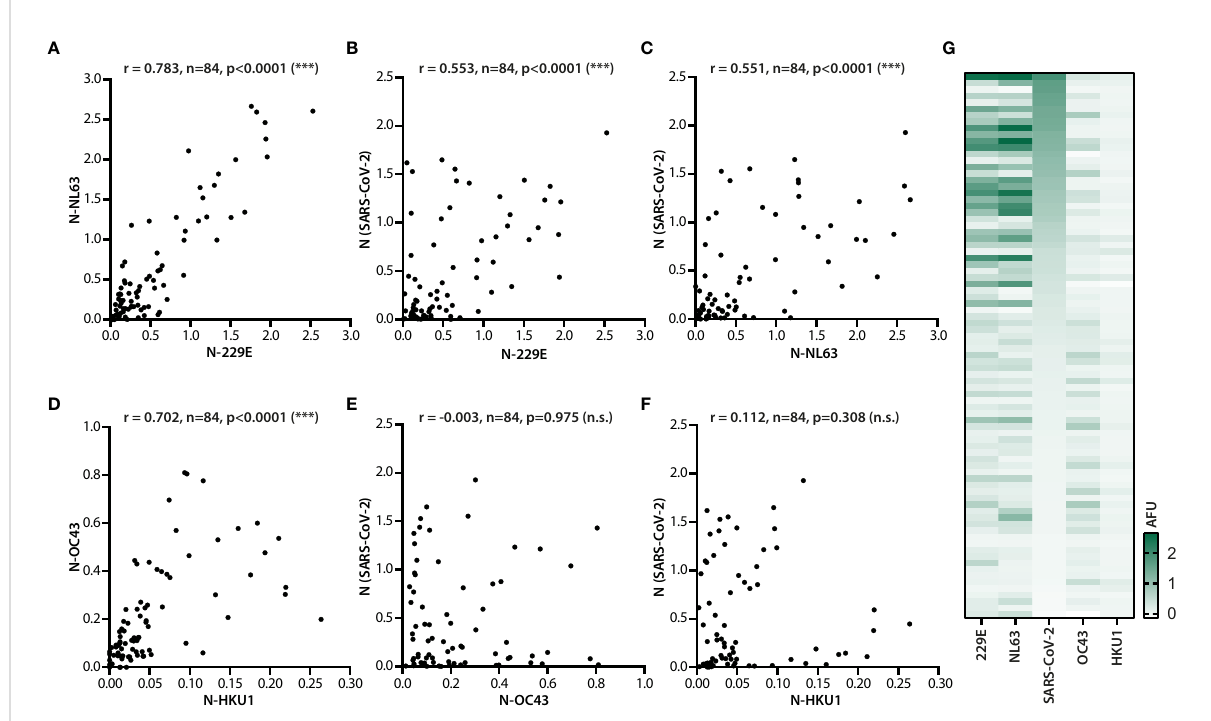
FIGURE 3 Correlation of IgG responses against N of different coronaviruses. Serum samples of 84 donors (n=84) were analyzed for IgG responses against N of SARS-CoV-2 and N of endemic coronaviruses 229E, NL63, OC43 and HKU1. (A) Correlation analysis of the antibody response against N of alphacoronaviruses NL63 and 229E. Correlation of the antibody response against N of SARS-CoV-2 and 229E (B) , as well as SARS-CoV-2 and NL63 (C) . Correlation analysis of the antibody response against N of betacoronaviruses OC43 and HKU1 (D) , N of SARS-CoV-2 and OC43 (E) , and N of SARS-CoV-2 and HKU1 (F) . Spearman correlation coef fi cient and p values are displayed. (G) Heat map analysis of the antibody response against N of 229E, NL63, SARS-CoV-2, OC43 and HKU1 in SARS-CoV-2 infected donors (n=84). The strength of the response was measured in AFU without applying cutoff and is depicted in green. Donors were sorted by decreasing titers against N of SARS-CoV-2. ns, not signi fi cant; ***,